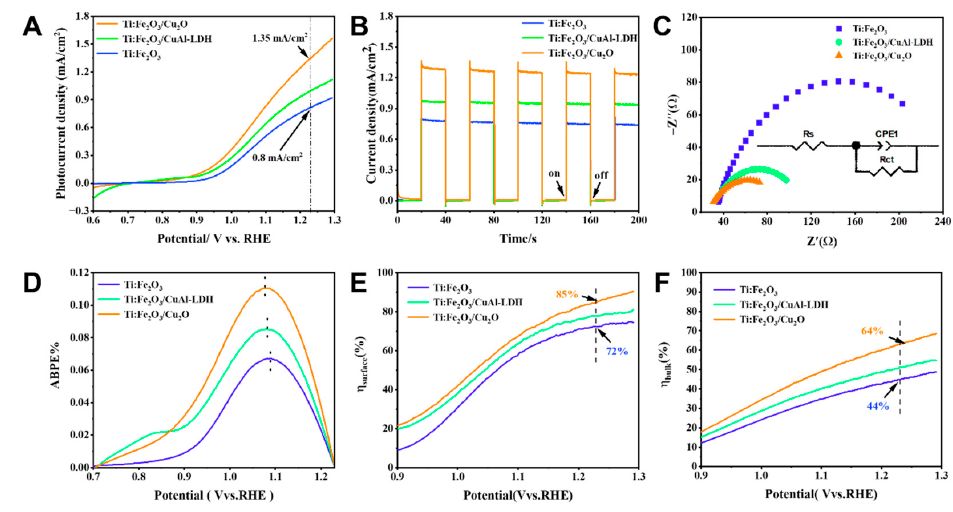
Figure 4. ( A ) Photocurrent density vs. applied potential (J-V) curve; ( B ) photocurrent density vs. time (I-T) curve; ( C ) the EIS Nyquist plot of the Ti:Fe 2 O 3 , Ti:Fe 2 O 3 /CuAl-LDH, and Ti:Fe 2 O 3 /Cu 2 O photoanode; ( D ) ABPE curve; and ( E , F ) surface and bulk charge separation efficiency of photoanodes. Table 1. Photocurrent density of Fe 2 O 3 , Ti:Fe 2 O 3 , Ti:Fe 2 O 3 /CuAl-LDH, and Ti:Fe 2 O 3 /Cu 2 O.